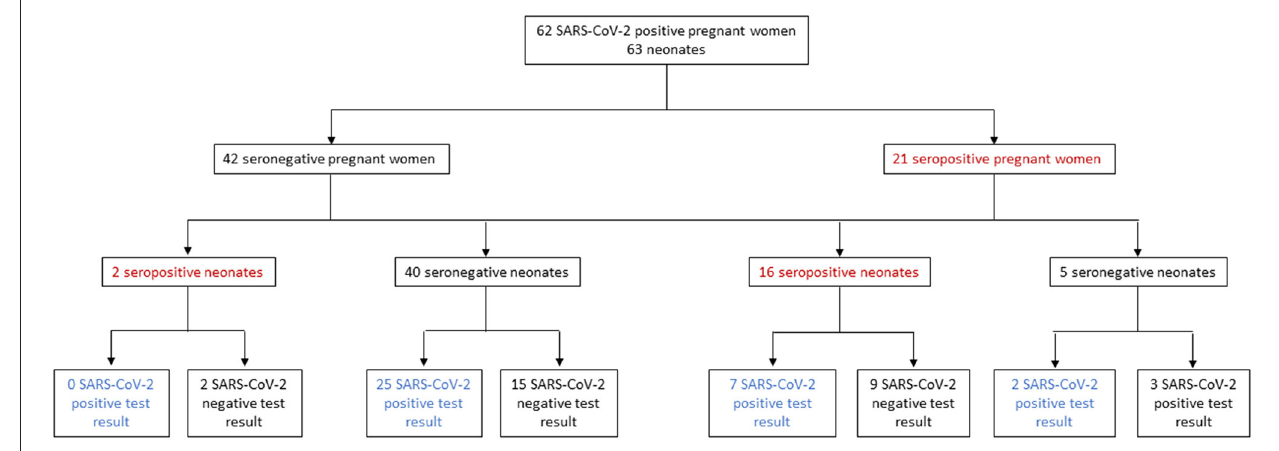
FIGURE 1 | Pregnant women and neonates included in the